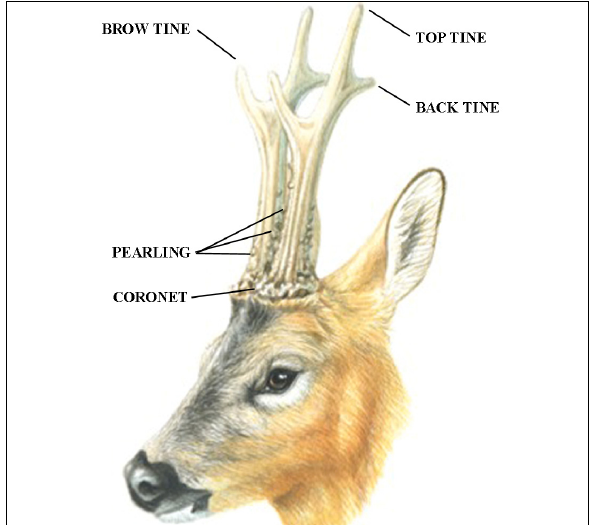
Figure 1. Parts of the roe deer